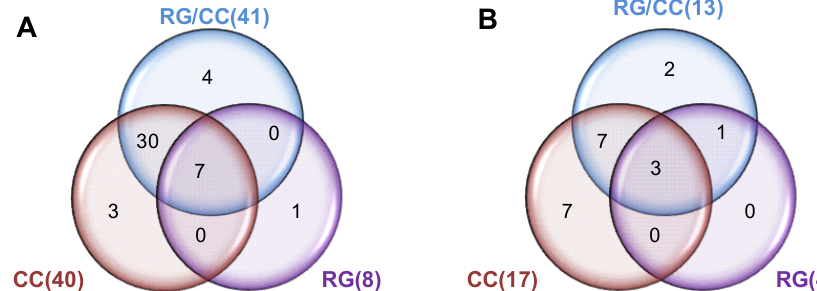
Figure 7. Venn diagrams showing unique or overlapped modulation of RG, CC, and RG/CC on HFD-induced biomarkers in sera of diabetic mice. The number in () was the modulated variables of the herbal medication on HFD-induced biomarkers compared to the model group. The numerical values in the diagrams depicted the metabolites that are unique to or shared between three medications. ( A ) ESI + mode; ( B ) ESI − mode.